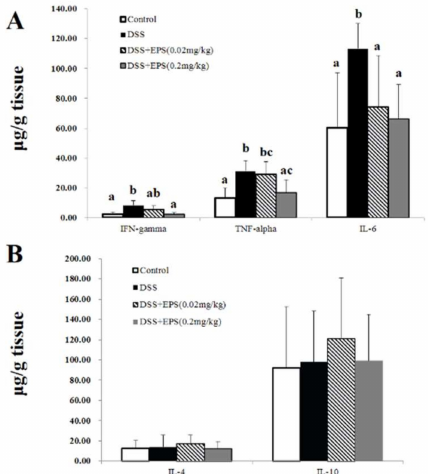
Figure 3. EPS-1 promoted a change in pro-inflammatory and anti-inflammatory cytokines. ( A ) The levels of pro-inflammatory cytokines in the colonic tissues from each treatment group. ( B ) The levels of anti-inflammatory cytokines in the colonic tissues from each treatment group. Values with different superscript letters (a, b, c) are significantly different ( p < 0.05).